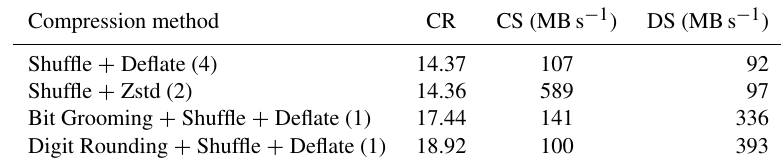
Table 12. Compression results for the simplified simulated SWOT L2_HR_PIXC pixel cloud product.